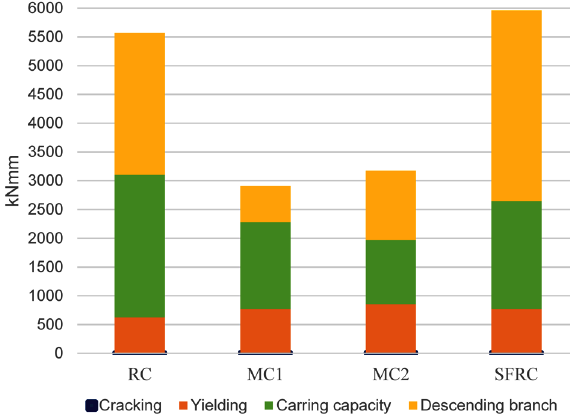
Fig. 8. The relation of energy absorbed and bending moment of beams